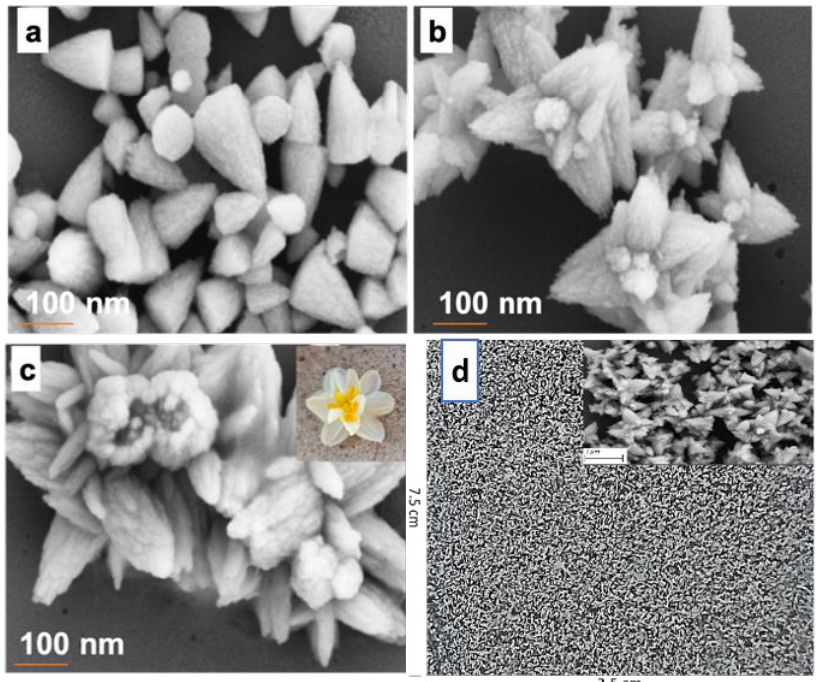
Figure 3. FESEM images formation of ZnS Nanostructure with different pH: ( a ) 9.5, ( b ) 10, and ( c ) 10.5. The inset of c is a real photo of the Narcissus flower. The films were prepared at Td = 65 °C, t = 10 min. Zn conc. = 0.2 M, Tu-conc. = 0.2 M. ( d ) Magnified digital camera photo showing the homo-